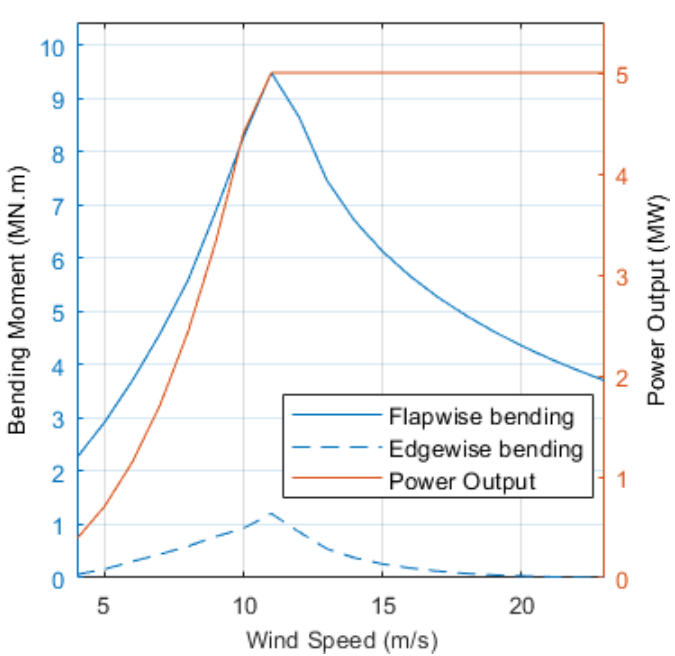
Figure 3. Mean bending moments and output power as a function of the wind speed.